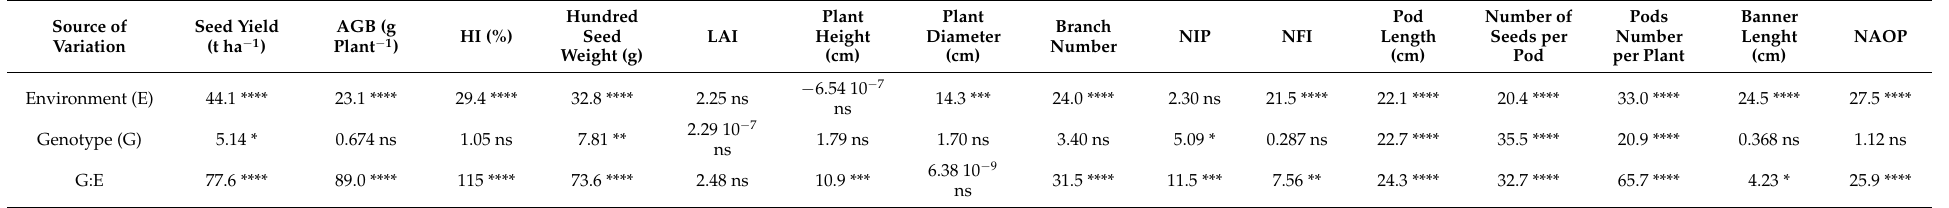
Table 2. Likelihood Ratio Test and Estimated Variance Components of 15 Faba Bean Landraces Evaluated for Three Consecutive Growing Seasons.